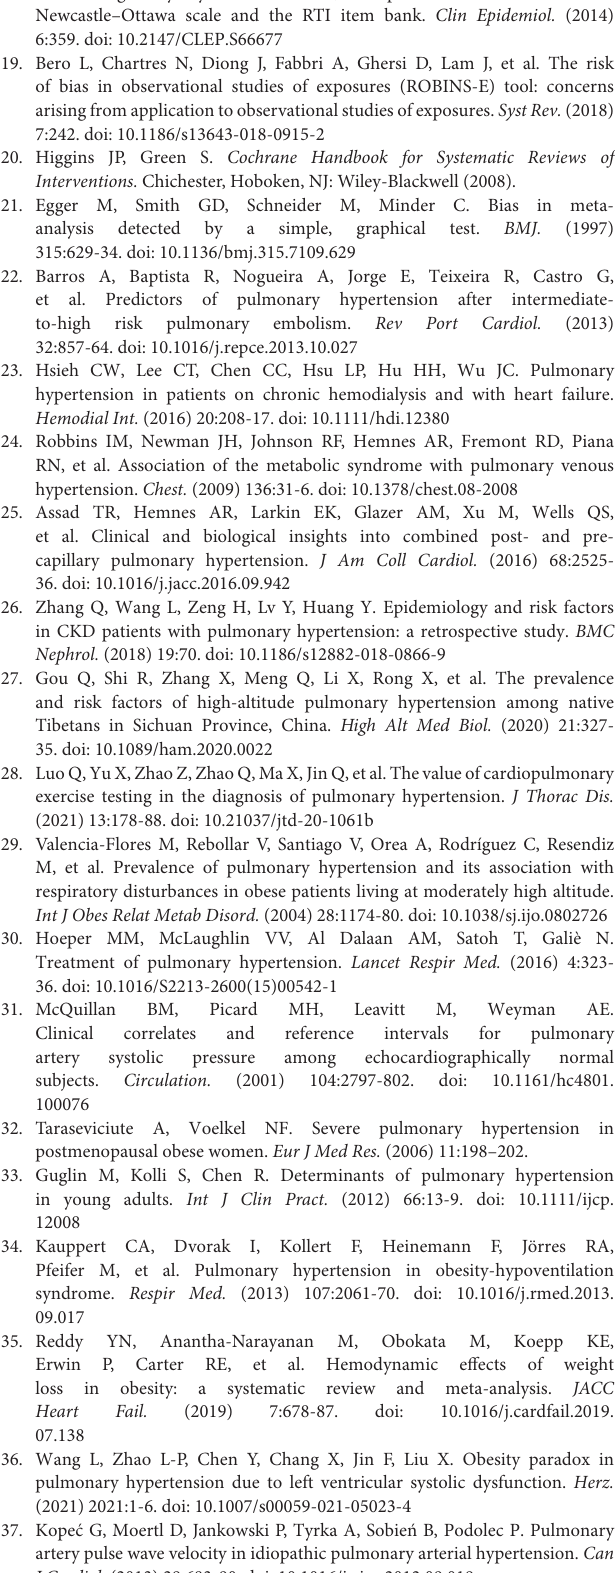
artery pulse wave velocity in idiopathic pulmonary arterial hypertension. Can J Cardiol. (2013) 29:683-90. doi: 10.1016/j.cjca.2012.09.019